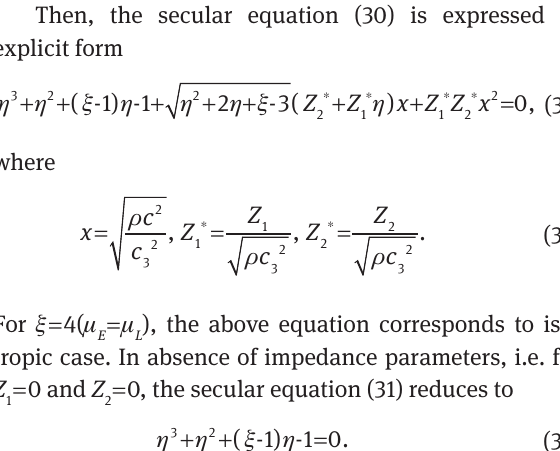
, Z when ξ = 5 and for ∗ = 2 -0.5 Z (solid curve), and ∗ = 1